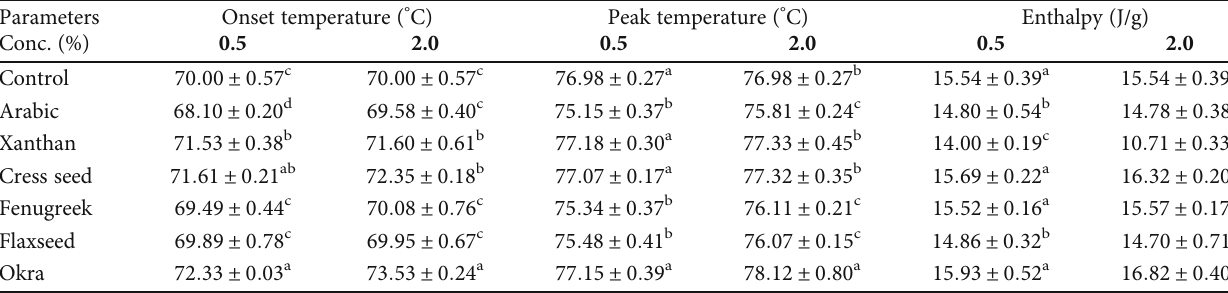
Table 5: E ff ect of gums on the DSC pro fi le of sweet potato